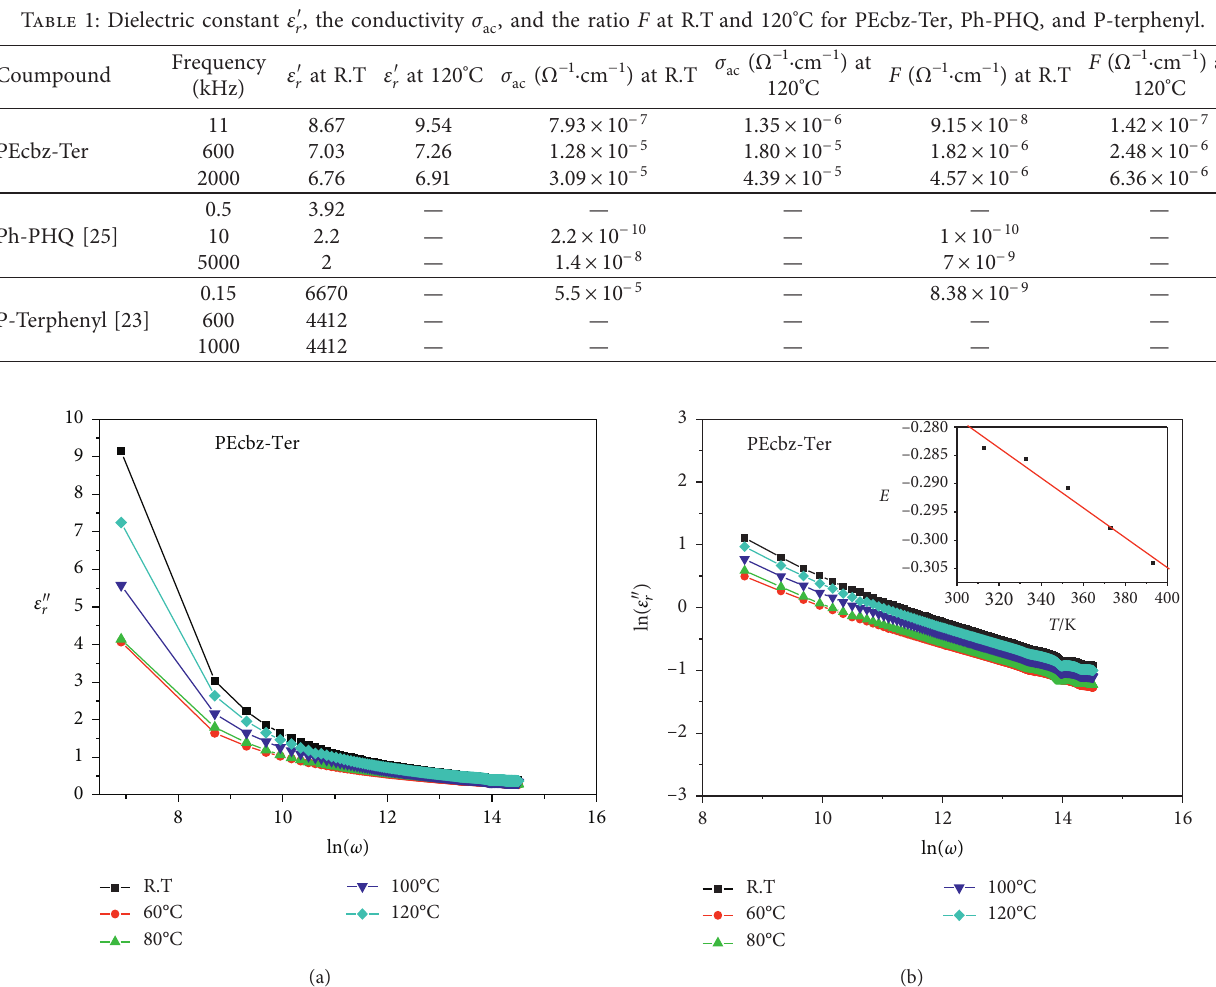
Figure 3: (a) Dielectric loss vs. frequency of PEcbz-Ter at different temperatures. (b) ln ( ε